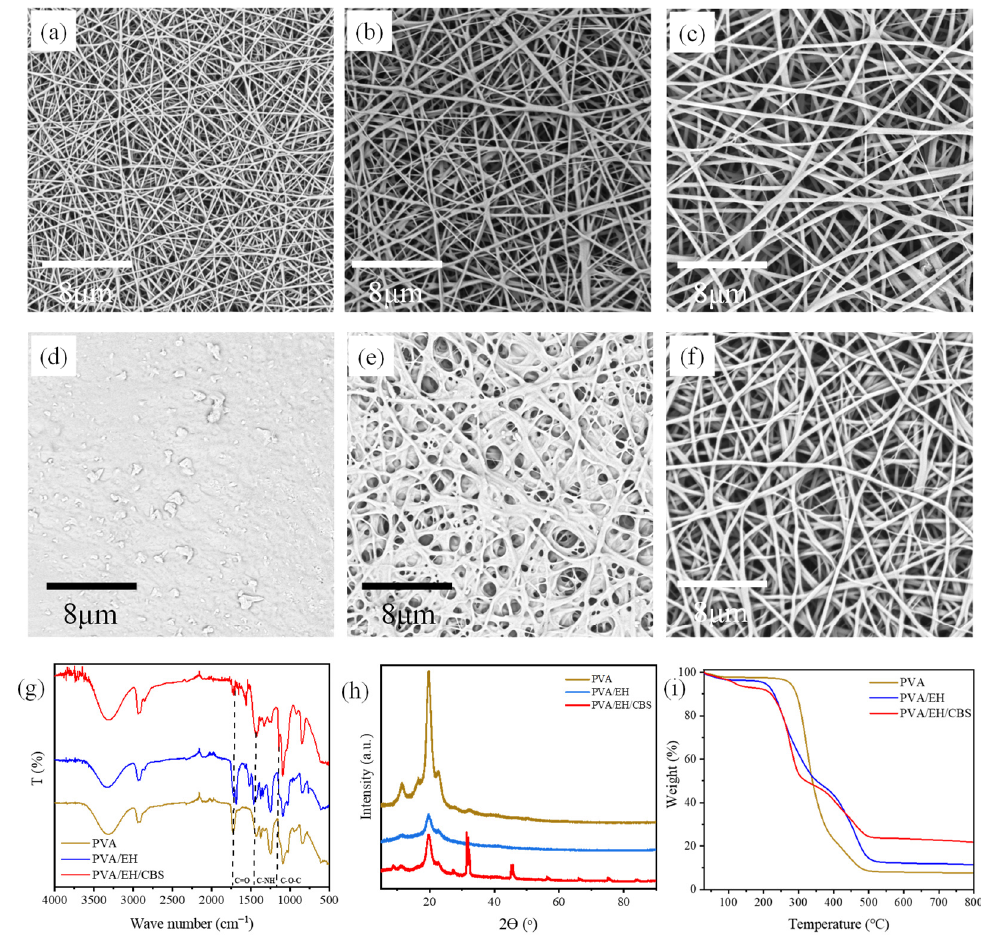
Figure 2. SEM images of ( a , d ) PVA nanofibers ( b , e ) PVA/EH nanofibers, ( c , f ) PVA/EH/CBS nanofibers before and after immersion in water, ( g ) FTIR spectra, ( h ) XRD patterns, ( i ) TG results of PVA, PVA/EH and PVA/EH/CBS nanofibers.